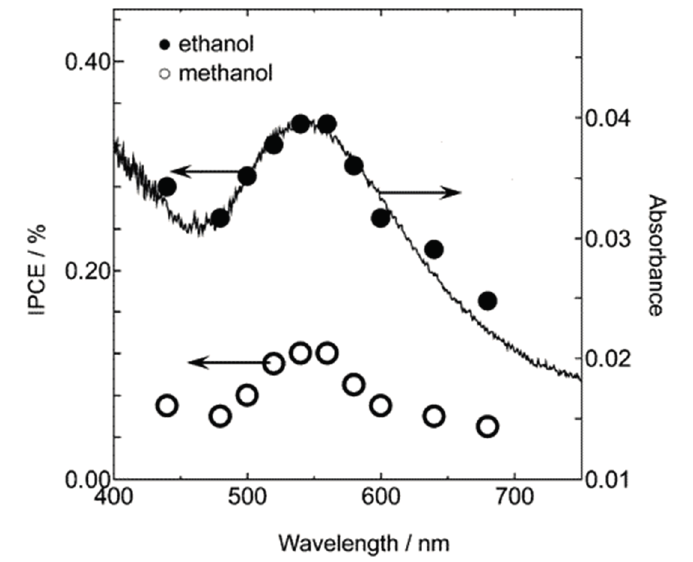
Figure 12. IPCE action spectrum in ethanol (methanol) photo-oxidation vs. LSPR (visible absorption) spectrum of gold in Au/TiO 2 (adapted from [149]; copyright (2005) American Chemical Society).